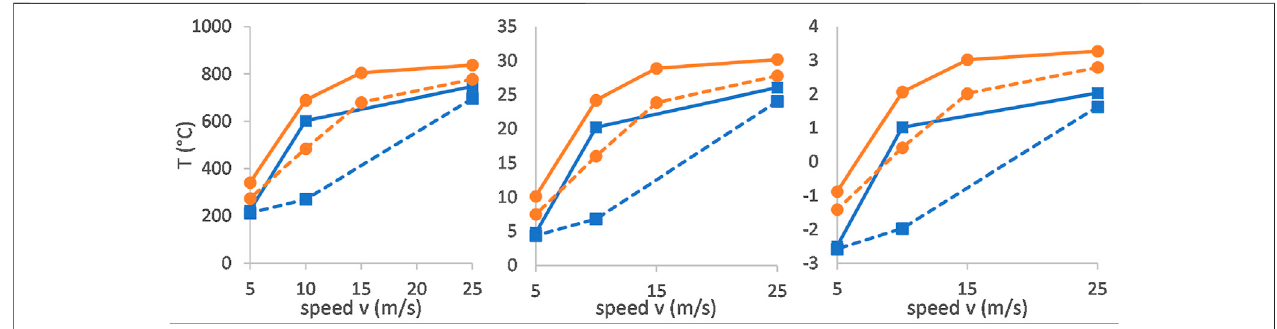
FIGURE5| Contactspottemperaturesofthe fl atski(bluesquares)andtheXCski(orange circles)vs.speedinthe fi rstrun(dashedlines)and lastrun(solidlines)of fi ve runs. Assumptive contact areas: 0.4% (left fi gure); 10% (middle fi gure); 50% (right fi gure).